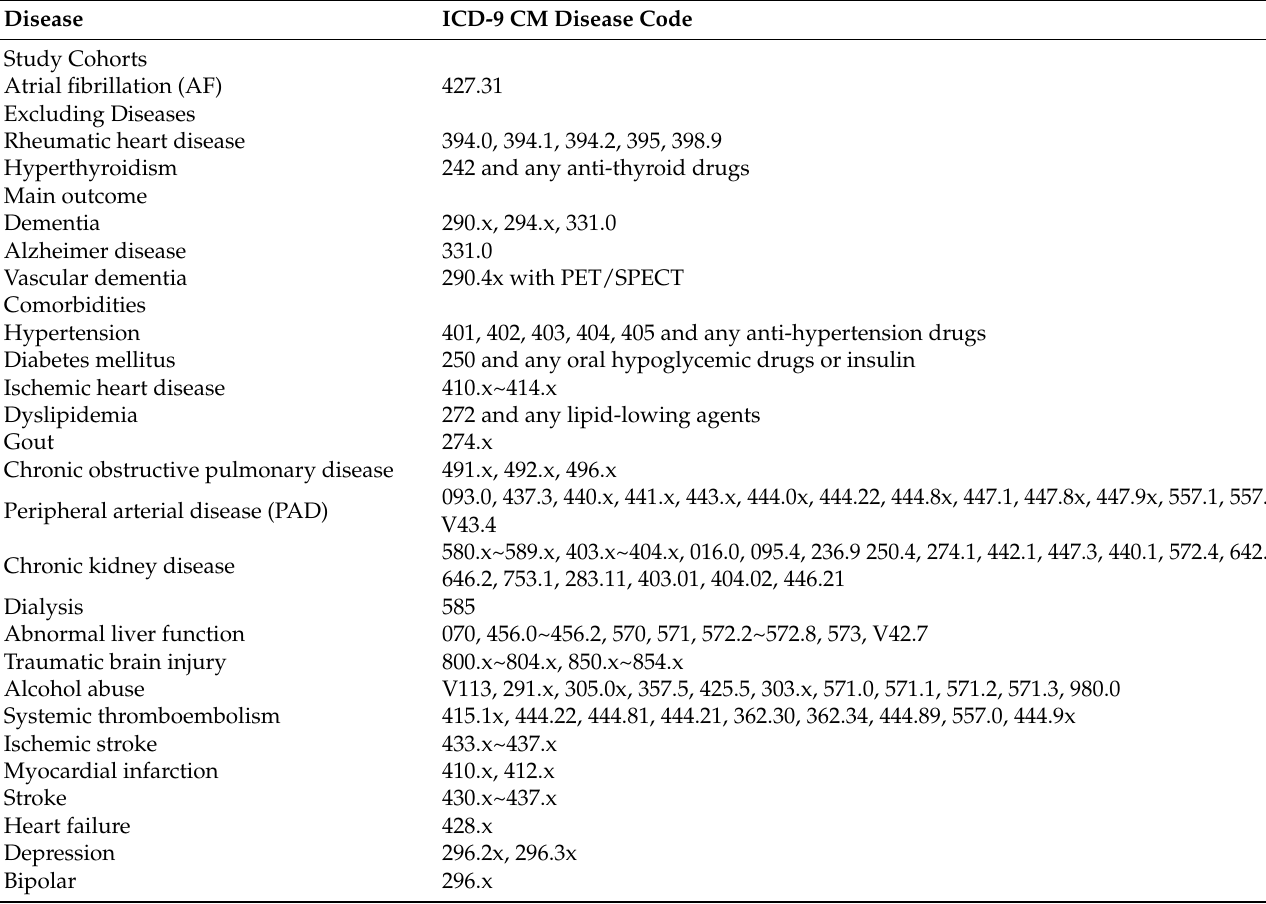
Table 1. Diagnoses used to define the cohorts, comorbidities, and